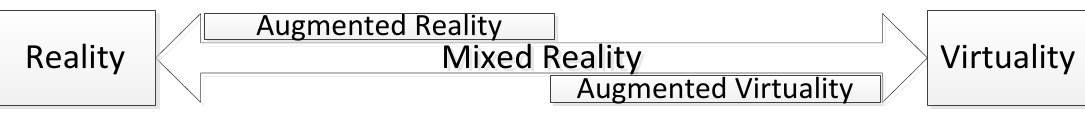
Figure 2. Simplified representation of a reality–virtuality continuum.